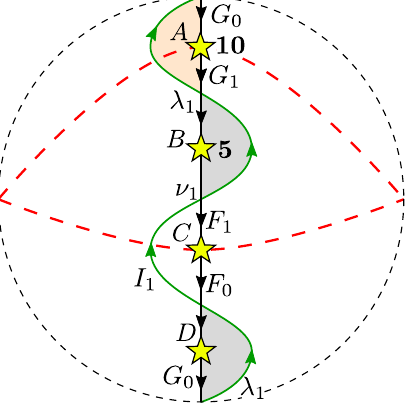
Figure 6 . Schematic structure of the (cid:12)ber of the mirror above the W = 0 point. The (cid:12)ber is topologically a disk with four punctures (denoted by stars), mapped here to a disk in which the dashed boundary should be identi(cid:12)ed to a point. The (cid:12)xed locus of the orientifold involution is given by the red dashed line. The green line denotes the intersection of the I 1 euclidean D2 brane with the Riemann surface, and the black segments between puntures indicate the location of the (cid:13)avor branes. We have also indicated by the shaded disks the worldsheet instantons giving rise to